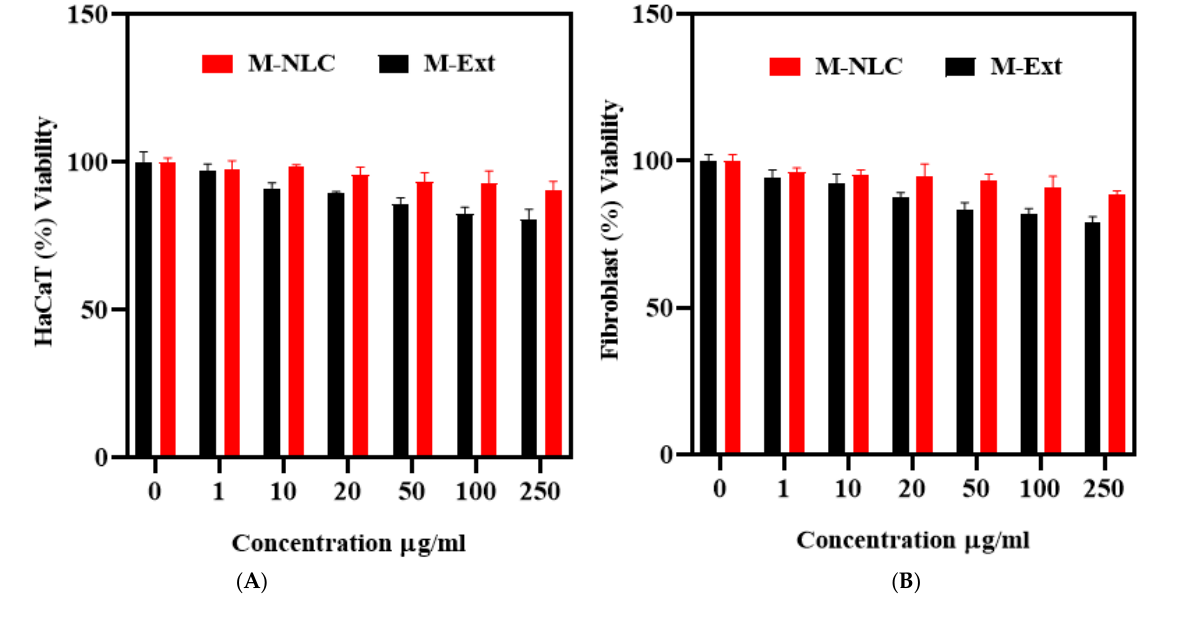
Figure 7. Cytotoxicity assay. Standard MTT assay was used to evaluate cytotoxicity of M-NLC and M-Ext on HaCaT cells ( A ) and Fibroblast cells ( B ). Data shown as means ± SD ( n = 3).